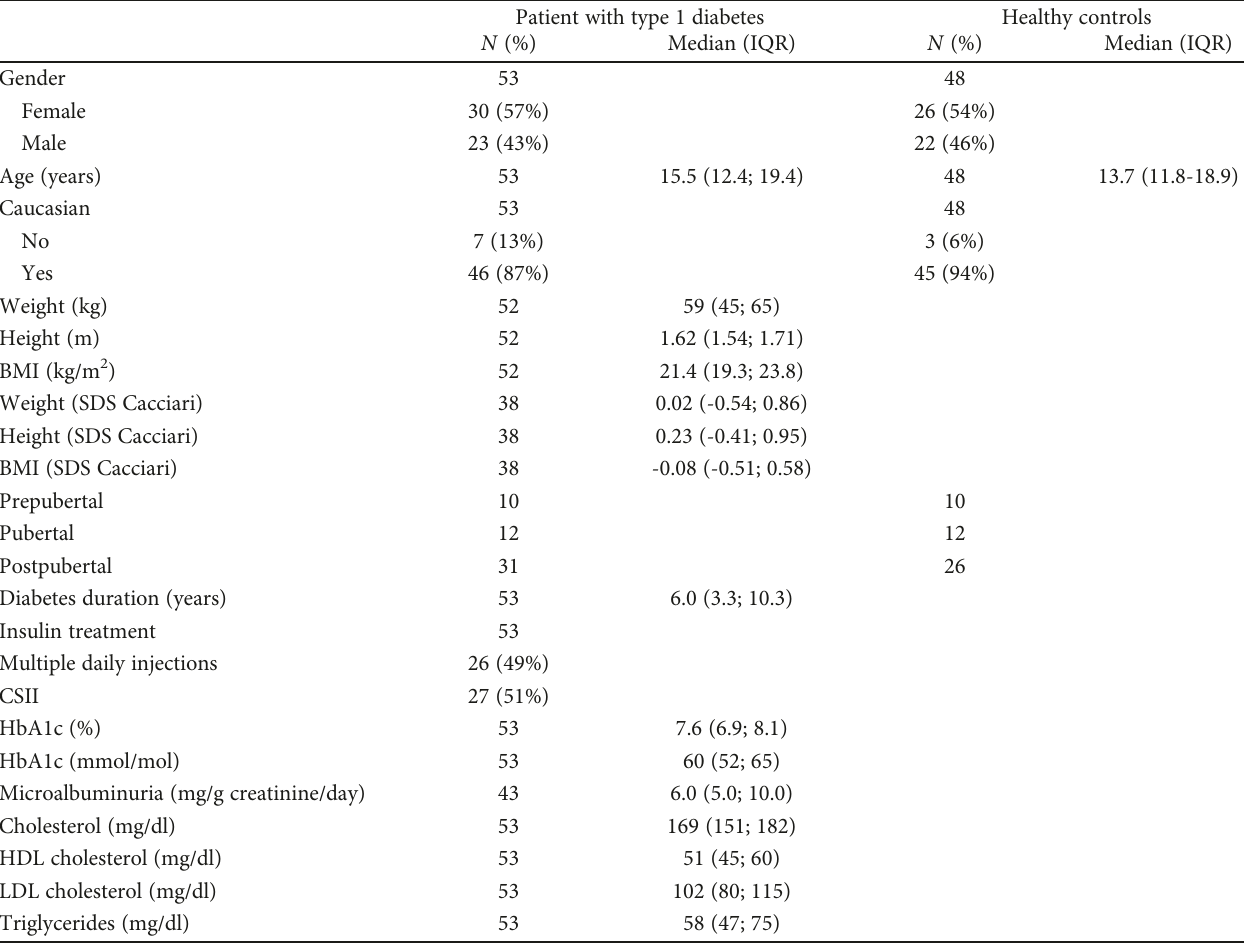
Table 1: Patient